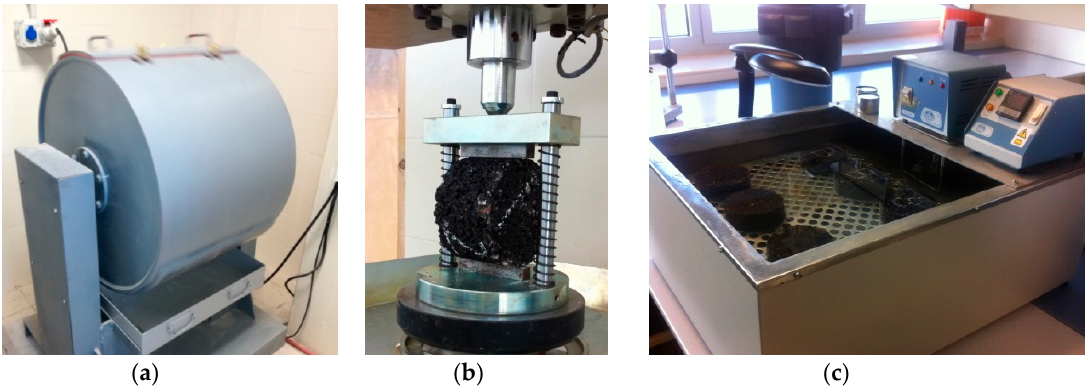
Figure 5. ( a ) Cantabro test; ( b ) ITS test; ( c ) thermostatic bath.